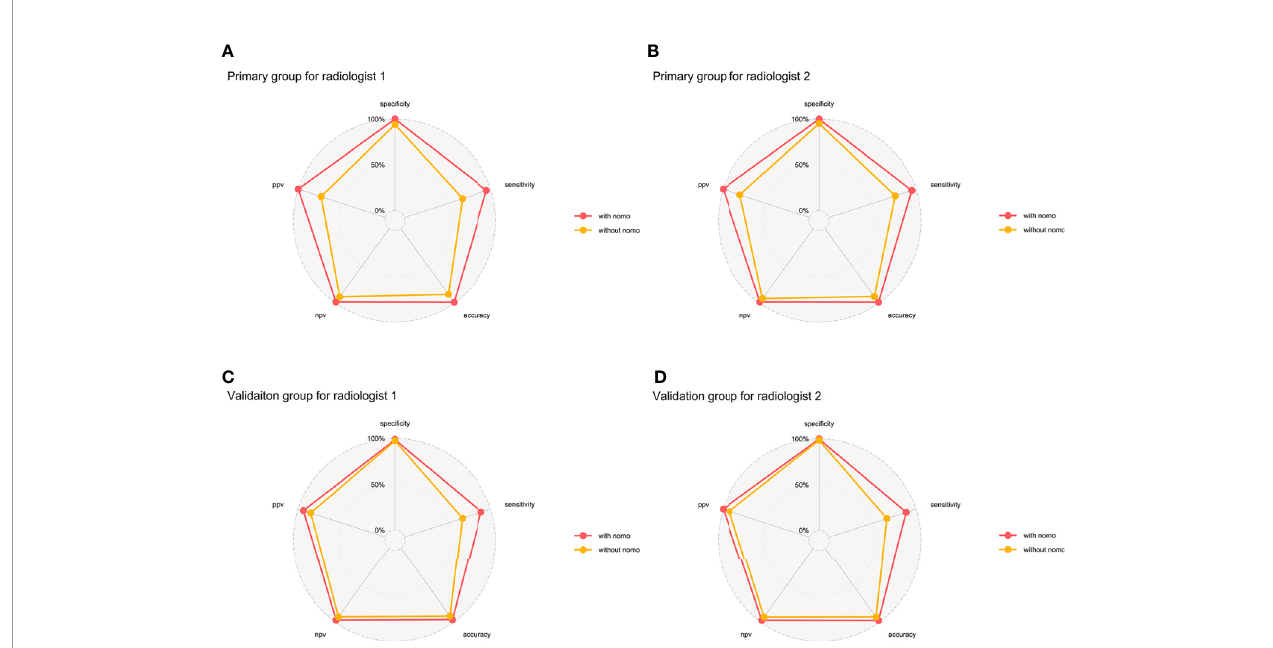
FIGURE 7 | Binary diagnosis of the two radiologists without and with the aid of a nomogram. (A, B) are for the primary group; (C, D) are for the validation group. PPV, positive predictive value; NPV, negative predictive value.